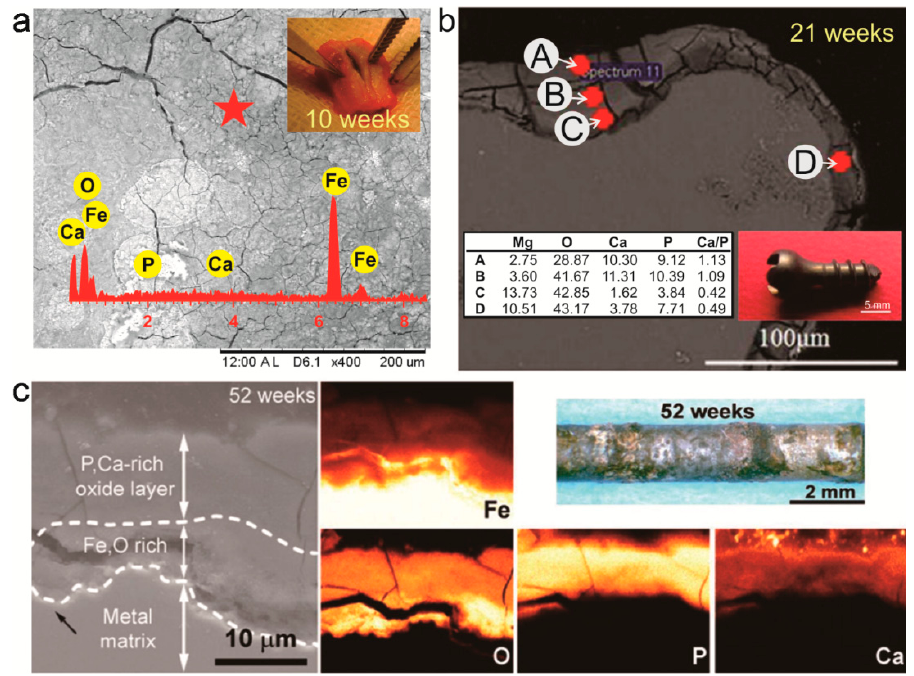
Figure 2. Scanning Electron Microscope-Energy-Dispersive X-ray Spectroscopy (SEM-EDS) analysis on the corrosion product of some retrieval implants: ( a ) surface of an Fe-bioceramic plate after 10 weeks implanted in sheep having undissolved corrosion product; ( b ) cross section of AZ31B Mg alloy screw after 21 weeks implanted in rabbit with attached corrosion product having different chemical compositions at different points on the surface; ( c ) cross section of pure Fe pin after 52 weeks implanted in rat showing the composition of corrosion product on the surface that differs depending on the distance from the implant interface. Adapted with permission from Elsevier and John Wiley and Sons [13,52,53].